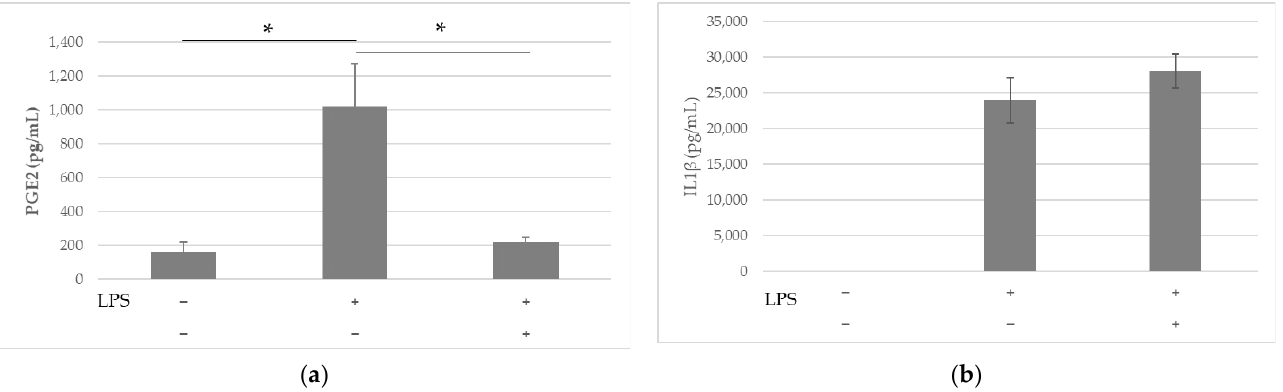
Figure 2. Concentration of ( a ) PGE2 and ( b ) IL1 β , in the supernatants of the PBMCs incubated with or without LPS (1 µg/mL) and with or without LS-E (50 µg/mL) for 24 h; results are presented as mean and standard error, n = 5, *: p ≤ 0.05.